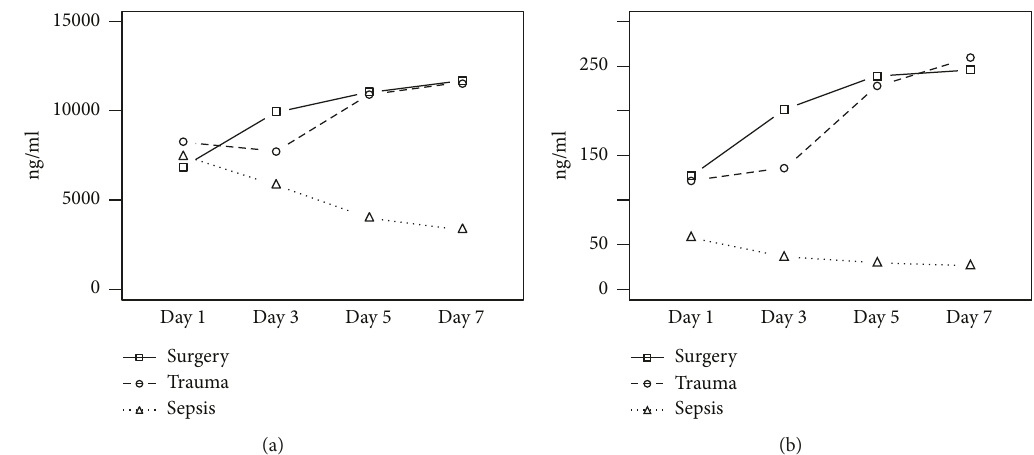
Figure 5: Comparison of calprotectin and calgranulin C kinetics after surgery, trauma, and the initiation of antibiotic therapy for sepsis, which was continued through day